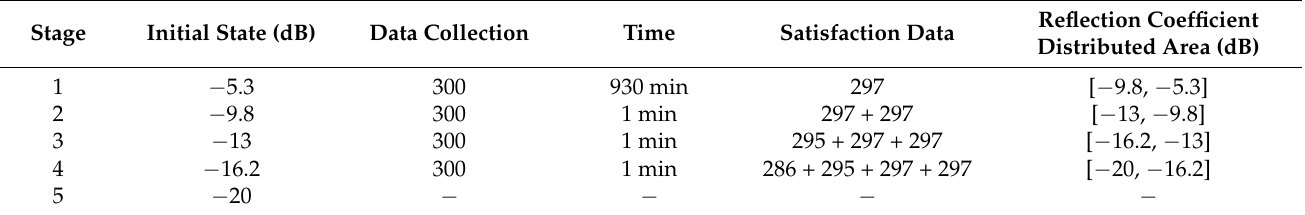
Table 1. Fourth-order cavity filter optimization process.